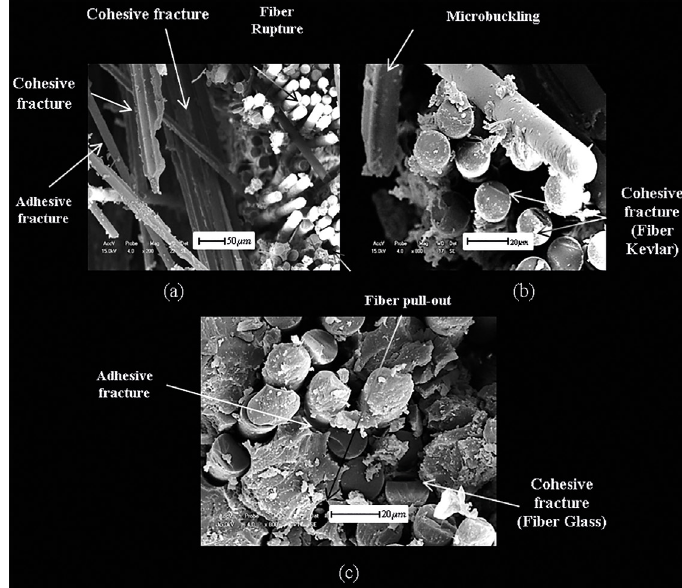
Figure 13. Fracture characteristics – HFCL laminate.